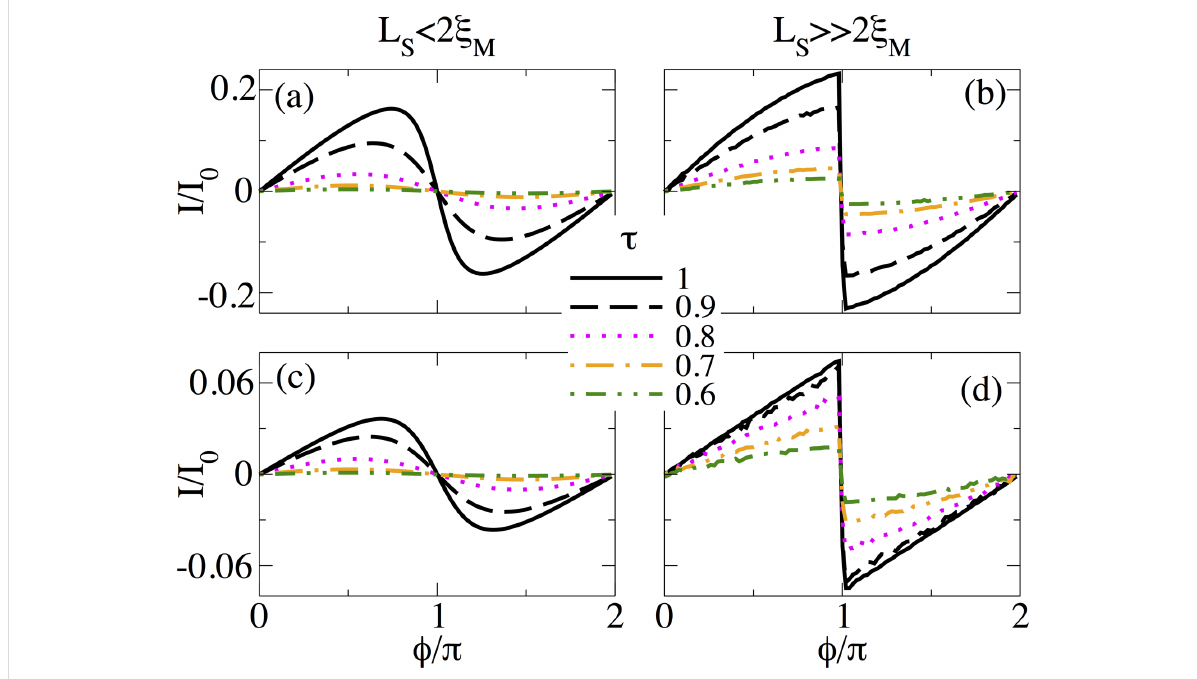
Figure 15: Effect of normal transmission through the coupling parameter τ on the supercurrent, I ( ), in (a,b) a short and (c,d) a long SNS junction. (a,c) L S = 2000 nm ≤ 2 ξ M and (b,d) L S = 10000 nm 2 ξ M . Although after decreasing τ the magnitude of the supercurrent at = π decreases, the sawtooth profile is preserved. Parameters: L N = 20 nm for short and L N = 2000 nm for long junctions, α R = 20meV·nm, μ = 0.5 meV, Δ = 0.25 meV and .